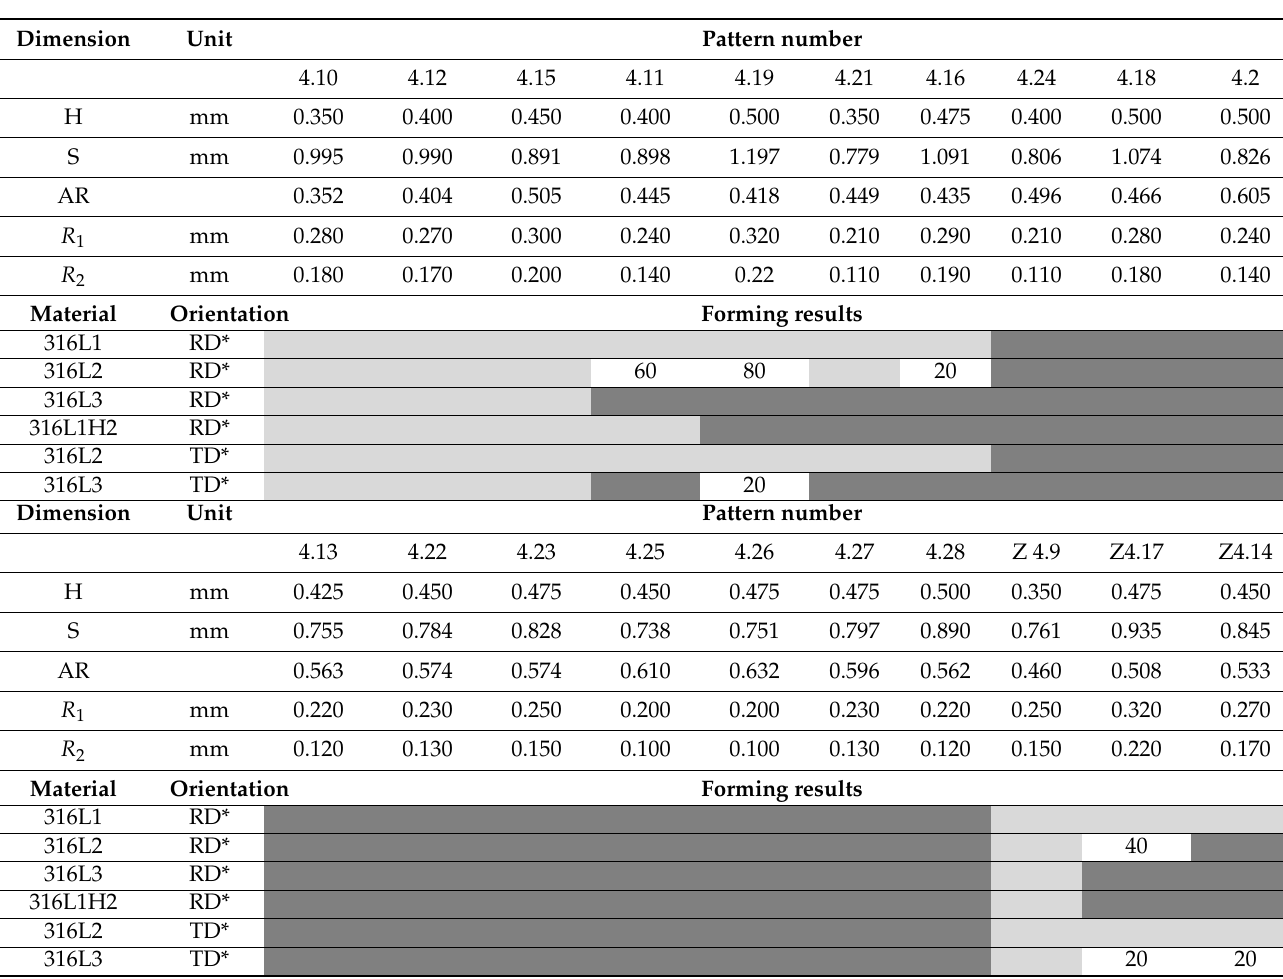
Table 3. Micro-stamping results with the successfully formed (light grey), partially formed (white) and failed (dark grey) shapes indicated. RD* and TD* are for samples positioned with the rolling direction and the transverse direction perpendicular to the micro channel length direction, respectively.